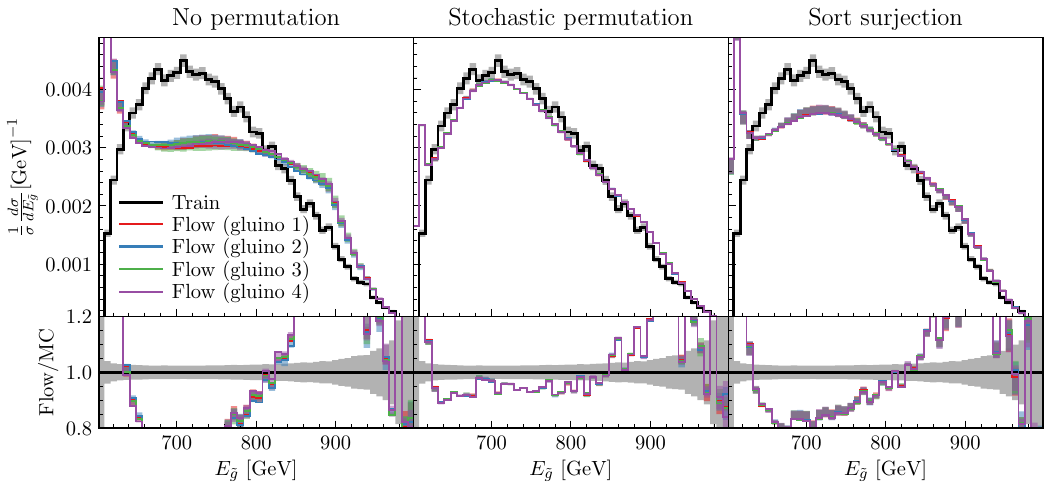
Figure 4: The energy distribution per individual gluino as predicted by models trained on 50k training events without permutation transform (left), with stochastic permutation (middle) or with sort surjection (right). The error bands correspond with variations between three independent